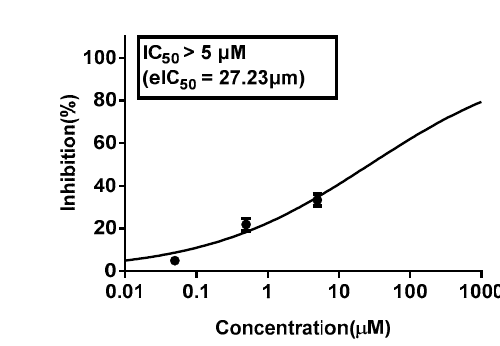
Figure 9. The inhibitory curve of AC at multiple concentrations on L-type calcium current. ( A ) normal hiPSC-CMs; ( B ) LQT syndrome hiPSC-CMs).